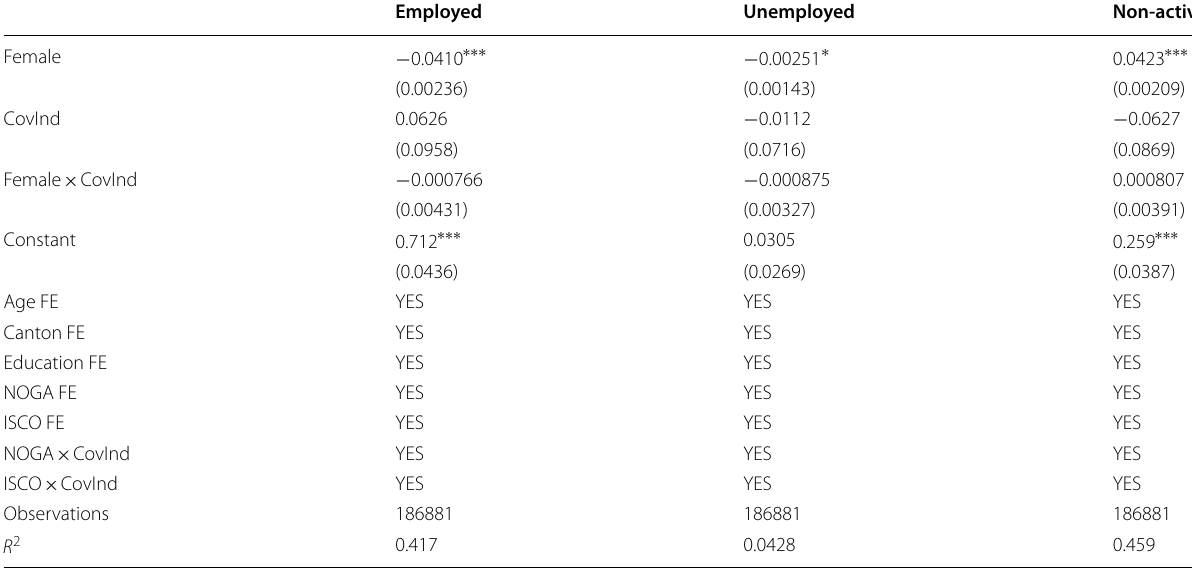
We show estimates from regression (1) of labor market status after adding the interaction of the COVID-19 stringency index and dummies for occupations and sectors as controls. Regressions estimated with linear probability model, including random effects. Robust standard errors in